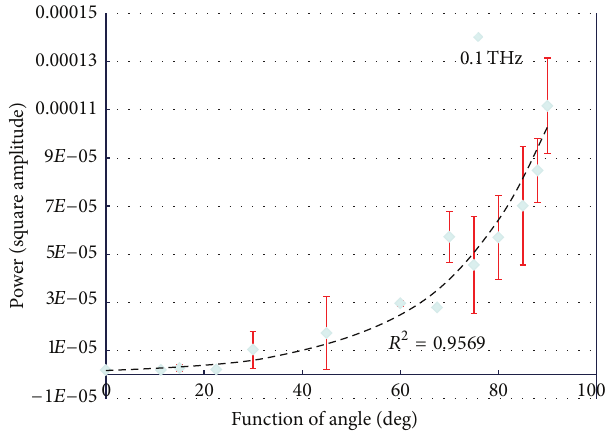
Figure 10: Angular dependence of transmitted power of THz terahertz waves through a 22-ply unidirectional carbon composite laminate.